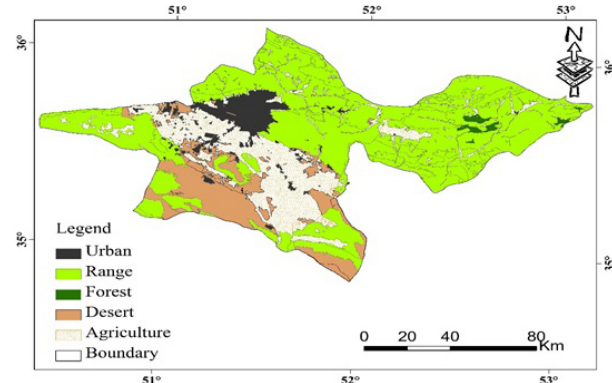
Figure 1. Location of Tehran and its different land